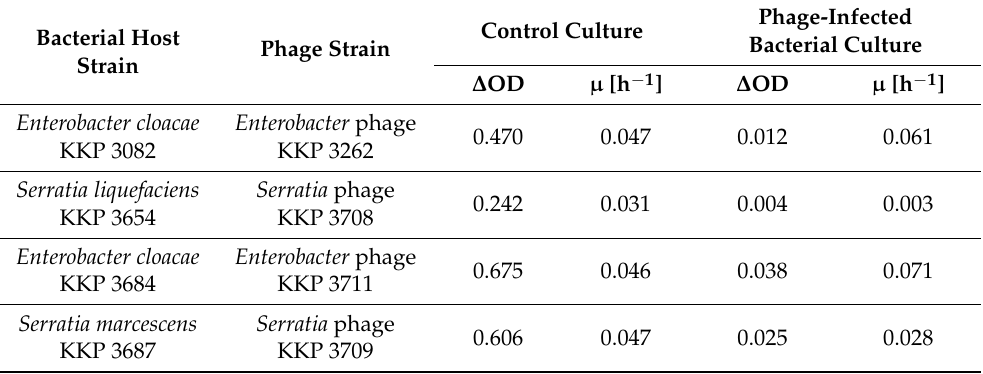
Table 1. Values of specific growth rate coefficients of the tested bacteria cultures after addition of specific phages ( n =